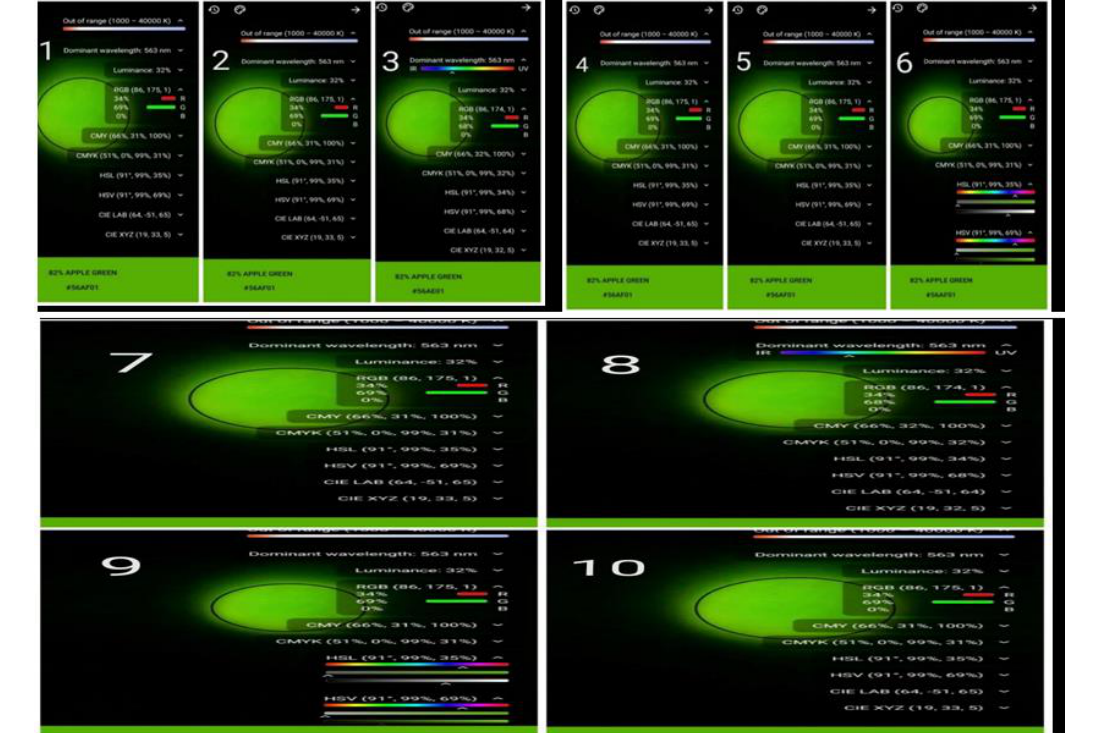
Fig. 4. Images of concordance study of concentration 4 mg/L.